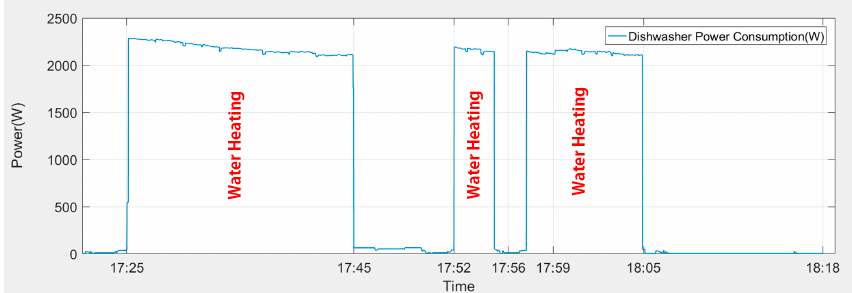
Figure 10. The power consumption of the dishwasher for the 65 °C power program.